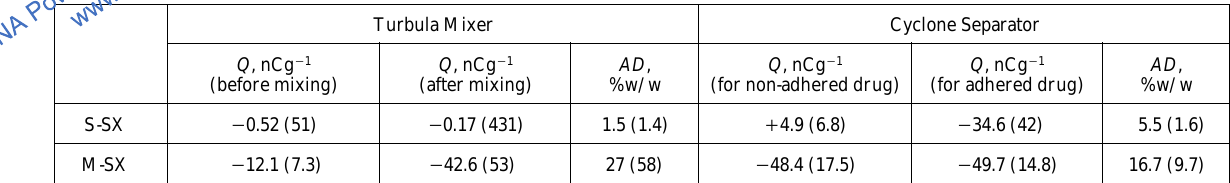
Table V Summary of the mean specific charge, Q , and mean adhesion fraction, AD , of supercritically-processed (S-SX) and micronised (M-SX) powders. The data represent the mean of three determinations with coefficient of variation (%